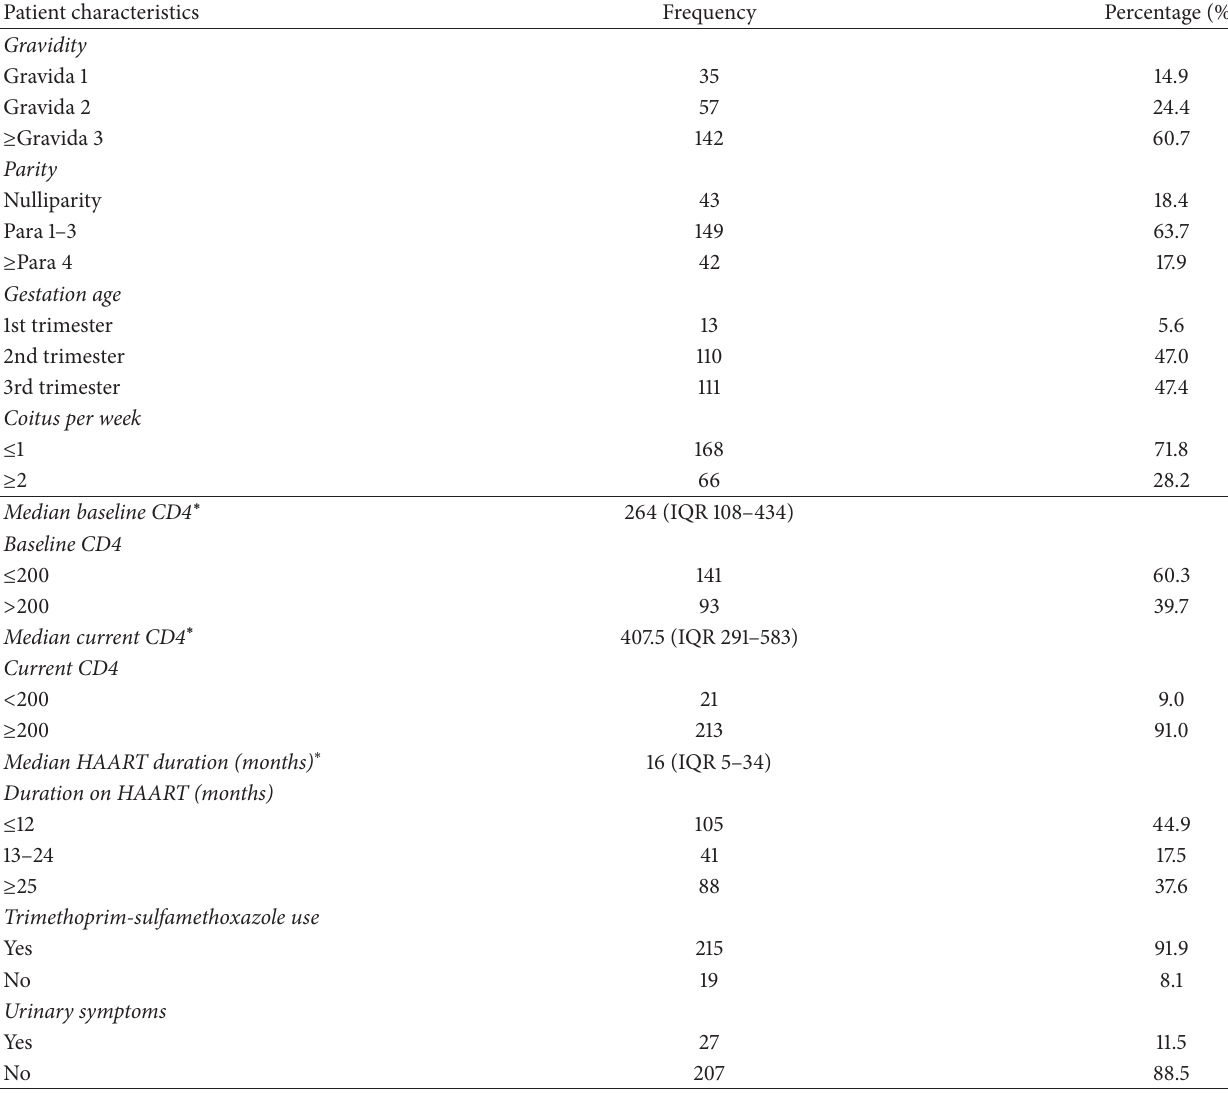
Table 2: Clinical and obstetric characteristics of HIV-infected pregnant women.